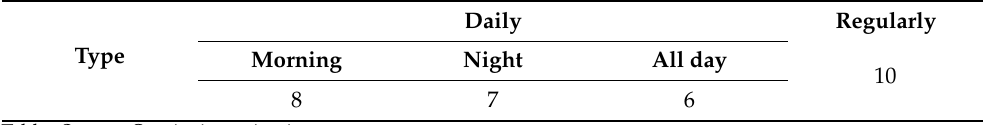
Table 1. By the end of 2018, the basic distribution of traditional fairs in the central urban area of Weifang